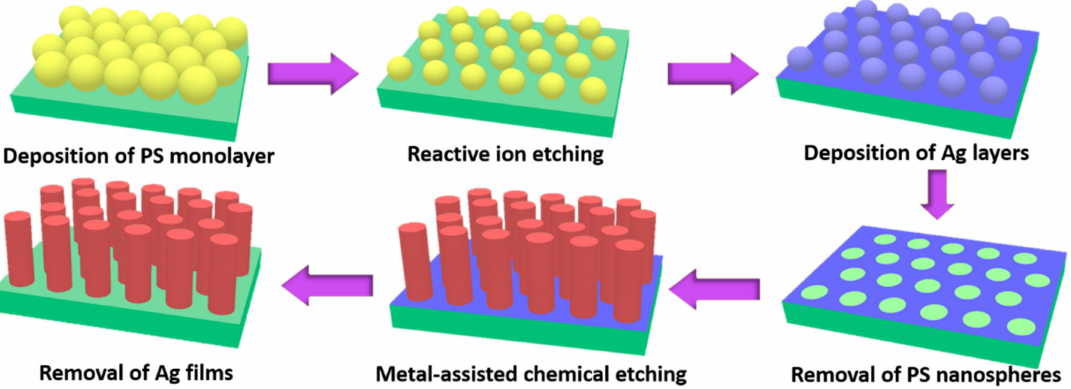
Figure 1. Schematic illustrations for the formation of regular SiNW arrays with dimension controllability. Anodic